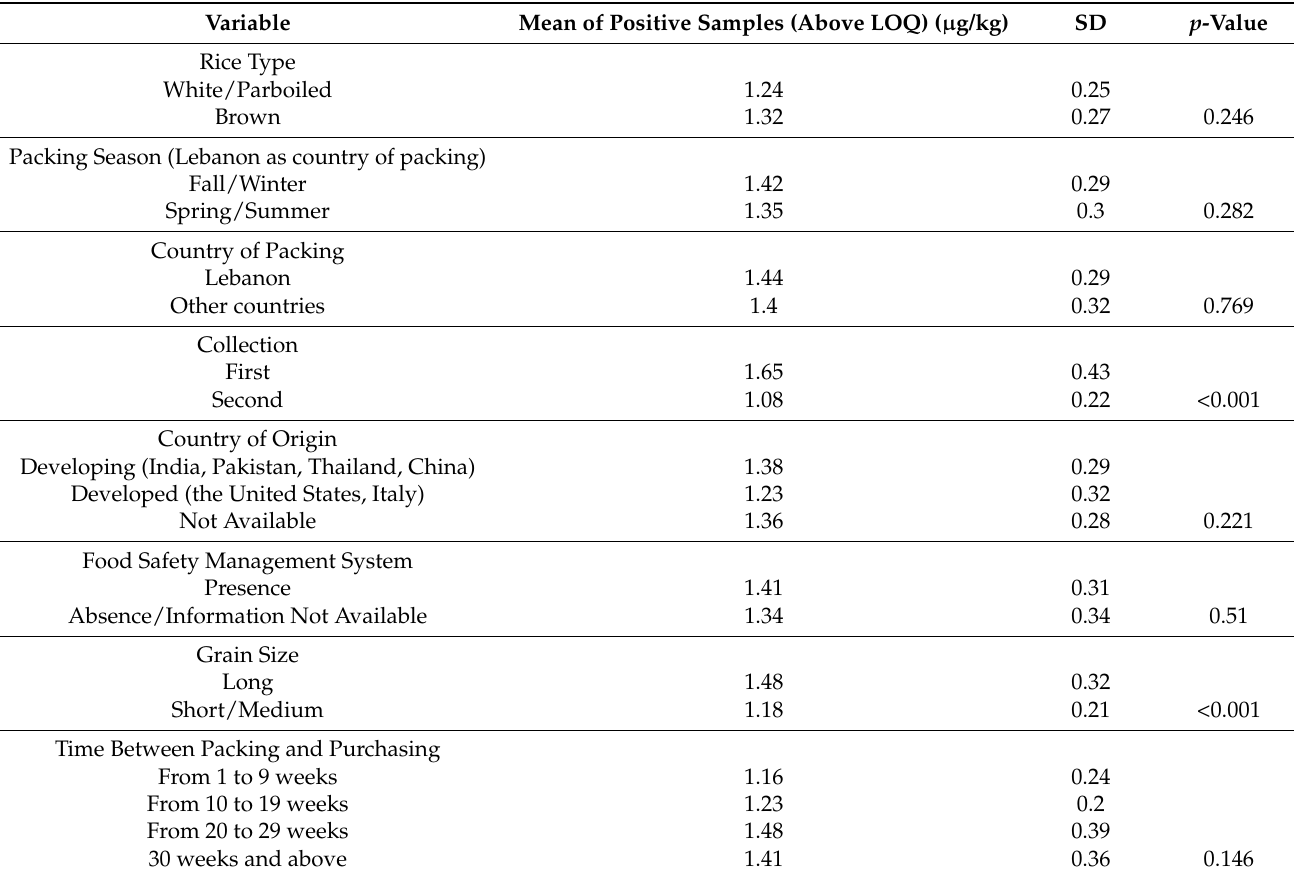
Table 3. Effects of different parameters on OTA in rice collected in